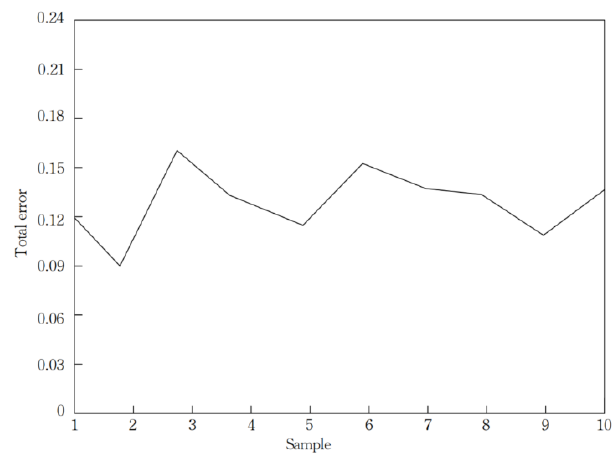
Figure 15. Error values of ten groups of test samples. Table 3. Average performance